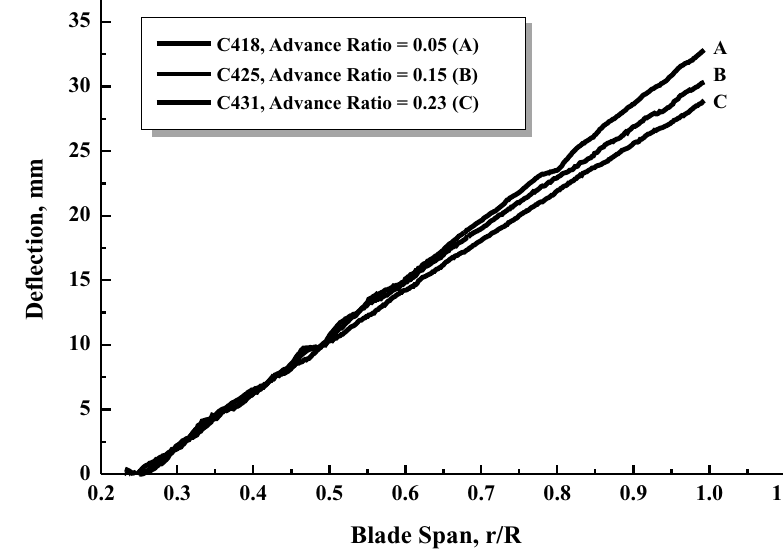
Blade Span, r/R Fig. 10. Effect of rotor advance ratio on blade deflection for blade #4, 25% chord, Ψ = 90 ◦ . Pixels corresponding to the 25% chord location, de- at 25% of the blade width, have been extracted from the fined as a line running parallel to the blade leading edge PMI processed data and plotted as a function of span